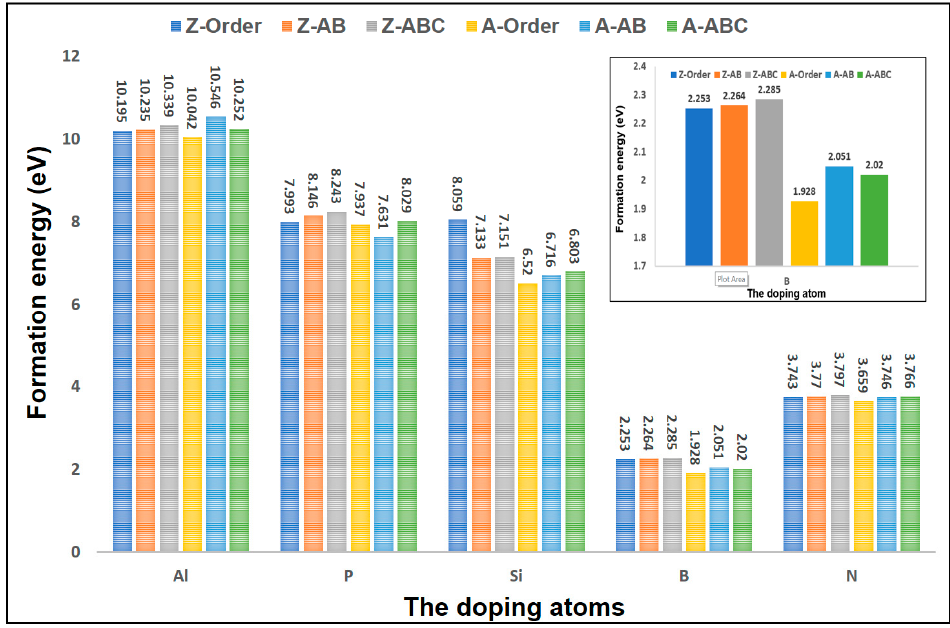
Figure 6. The formation energy of the stacked graphene with three layers doped with five atoms, namely, Al, P, Si, B, and N. The inset illustrates the formation energy of the stacked graphene doped with B.